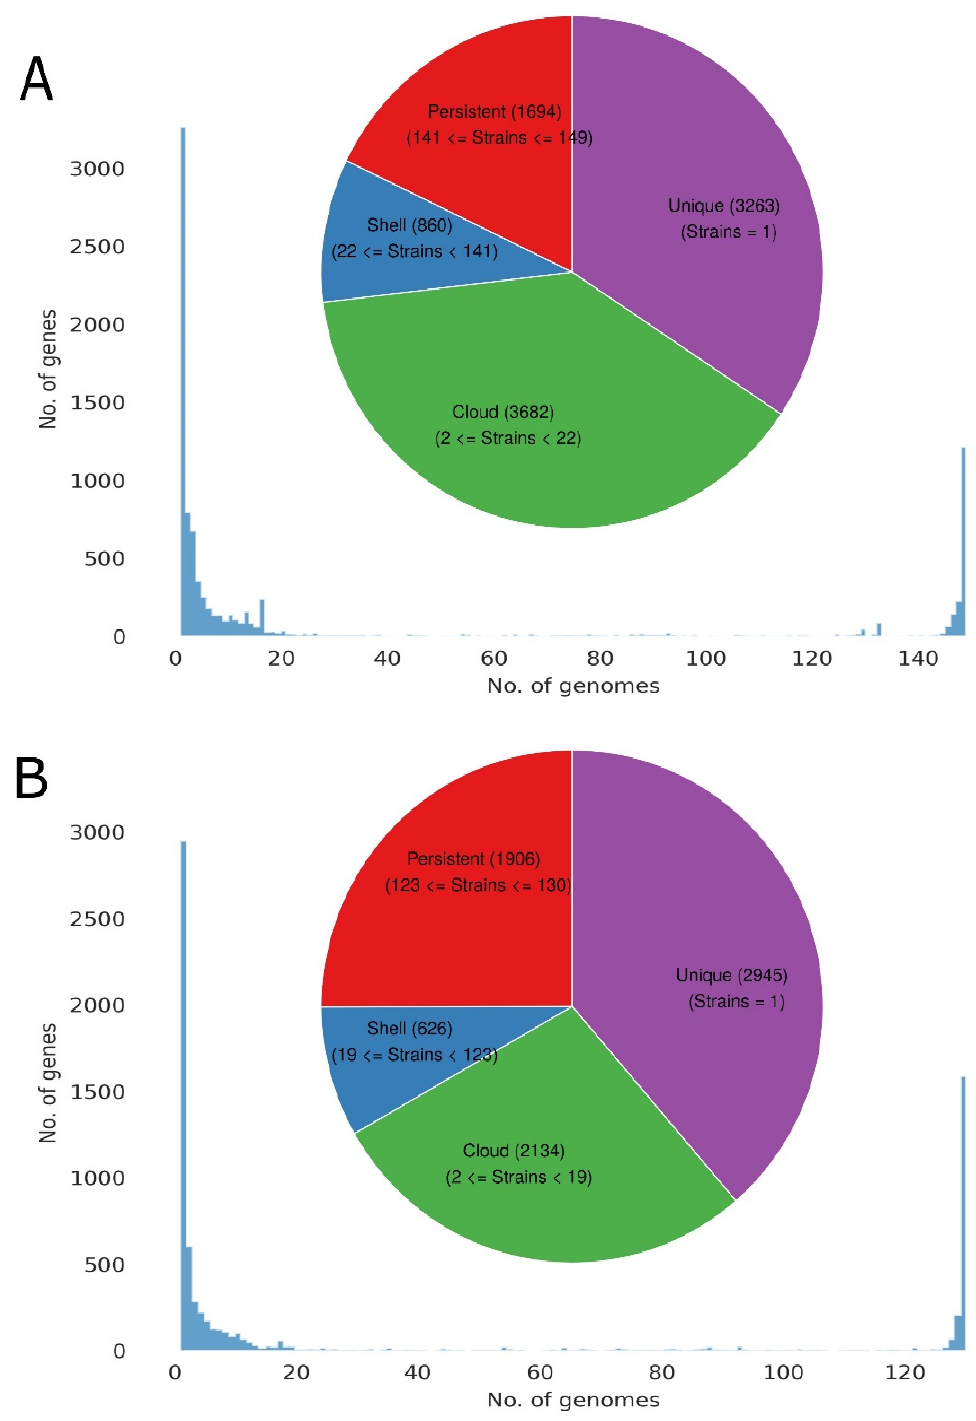
Figure 2. Distribution of pan-genome to the core, shell, cloud, and unique genome. ( A ) The pan- genome distribution of 149 strains. ( B ) The pan-genome distribution of 130 strains.